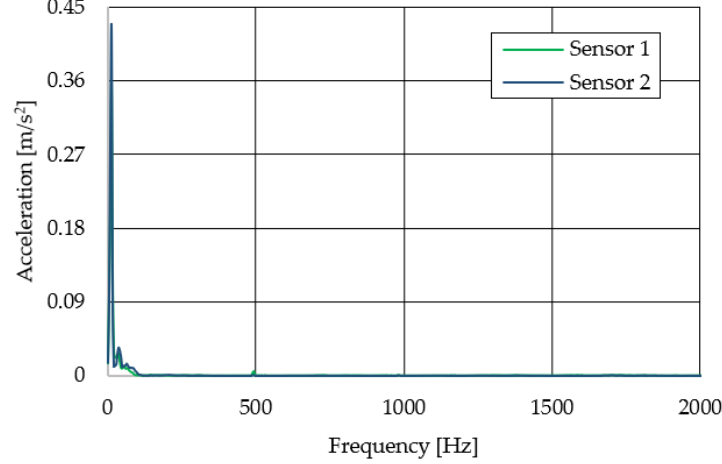
Figure 24. Comparison of the frequency waveforms in the y -axis during asymmetrical crossing over the obstacle by the right wheel.